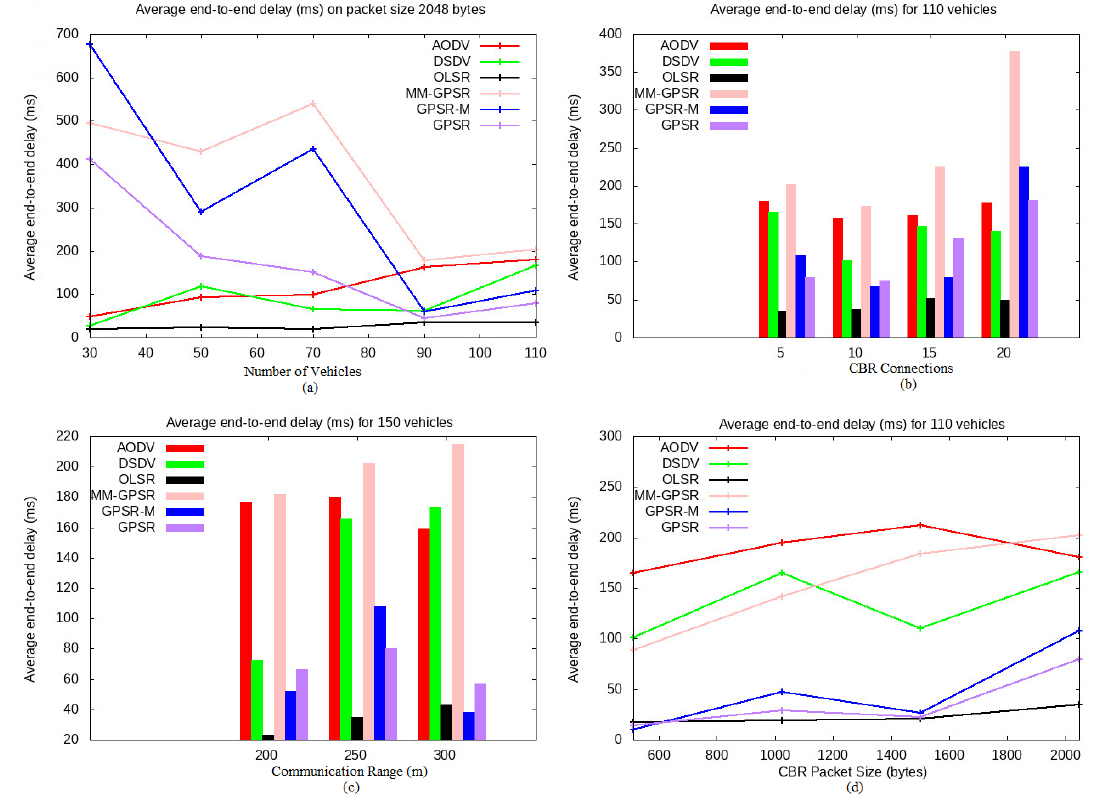
Figure 7. AEED results on various network